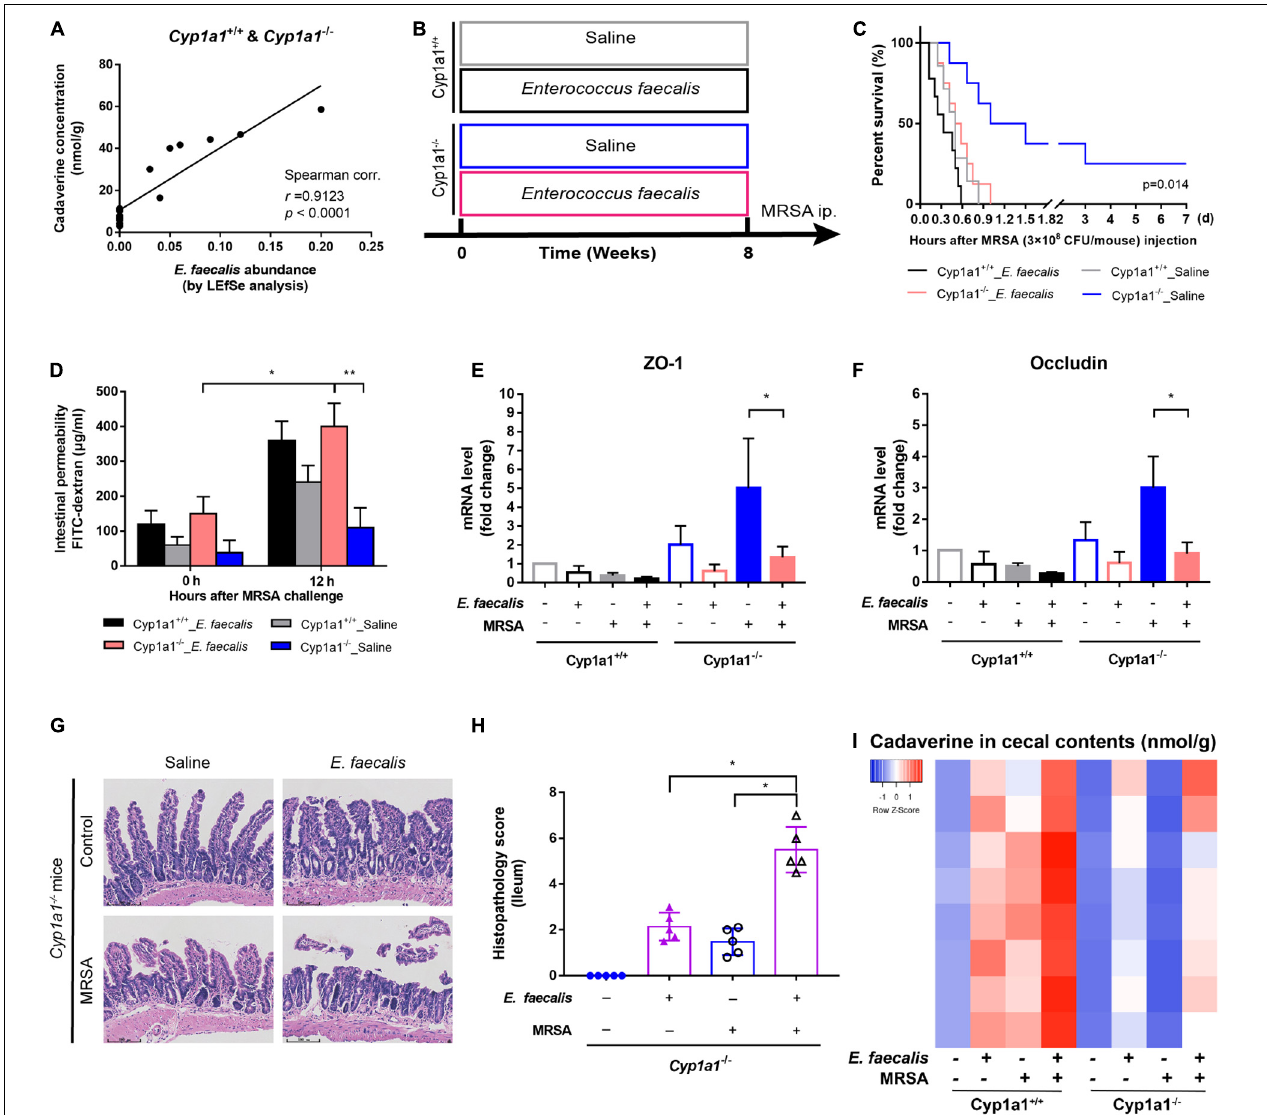
FIGURE 5 | Cadaverine-producing Enterococcus faecalis causes gut barrier disruption and increased mortality. (A) Correlation analysis between the cadaverine (CAD) level and paired E. faecalis abundance in the caecal contents from Cyp1a1 + / + mice and Cyp1a1 − / − mice with MRSA infection. (B) Cyp1a1 + / + mice and Cyp1a1 − / − mice were treated daily with saline or E. faecalis (4 × 10 7 CFU) by oral gavage for 8 weeks. E. faecalis treatment of Cyp1a1 − / − mice led to (C) increased mortality, (D) higher fluorescein isothiocyanate (FITC)-dextran concentration in serum, and reduced mRNA levels of (E) zonula occludens (ZO)-1 and (F) occludin in the ileum epithelium. (G) Representative H&E staining in the ileum from Cyp1a1 − / − mice with or without E. faecalis treatment. Scale bar, 100 µ m. (H) Histological scores of the ileum in each group ( n = 4–5). (I) Heatmap of the caecal contents from each group. Error bars, ± SEM. * P < 0.05, ** P <